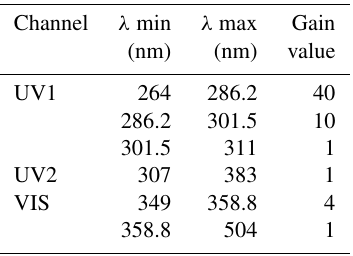
Table 3. Electronic gain values for different channels and spectral